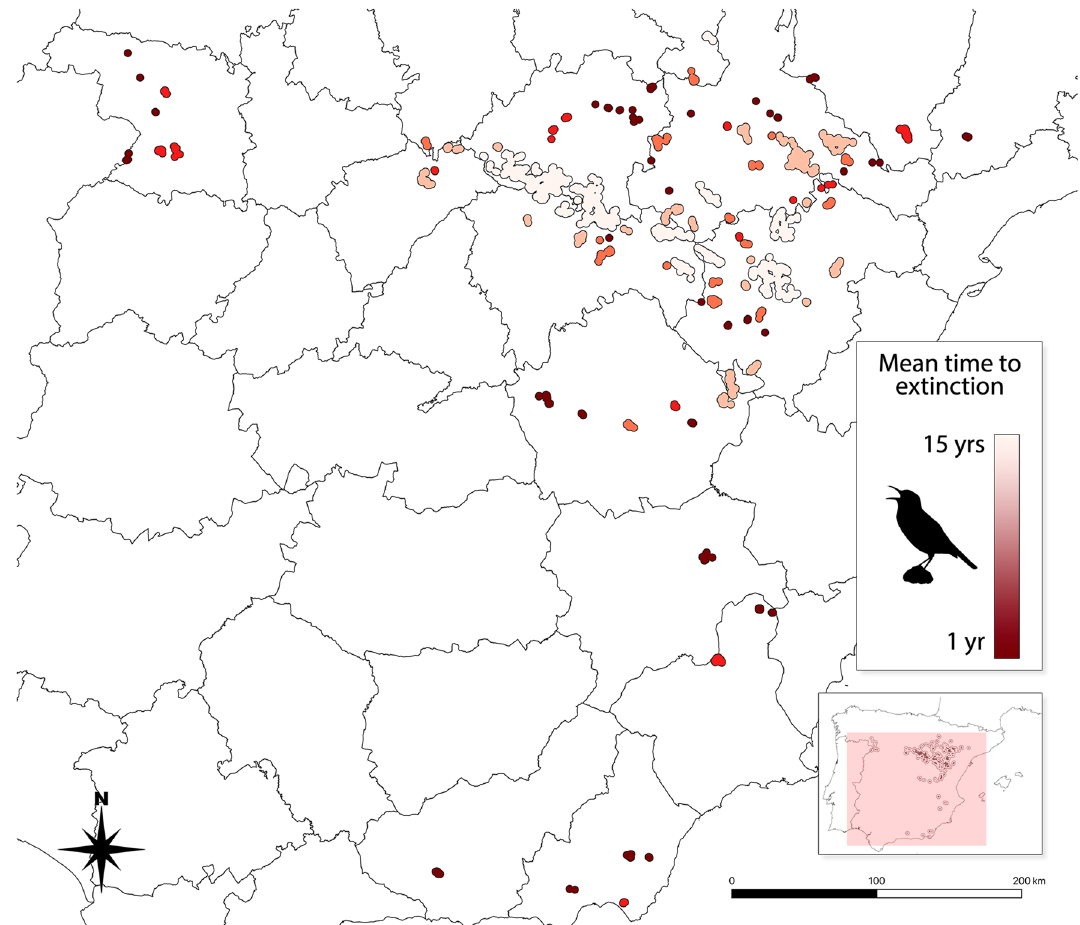
Figure 4. Mean time to extinction of the 100 subpopulations conforming Dupont’s Lark metapopulation in Spain. The PVA model predicts the extinction of the last subpopulations in around 15 years (center of the distribution). The peripheral subpopulations face imminent extinction (dark maroon